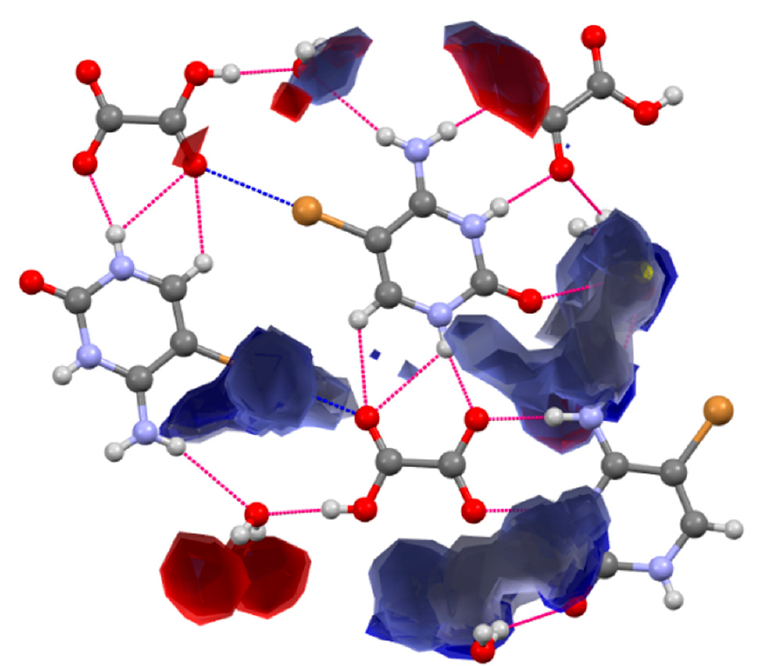
Figure 7. Visualization of the full interaction map calculated around the content of the asymmetric unit for compound ( VI ). Region of HB acceptor and donor likelihood are shown in red and blue, respectively. Acceptor peaks for halogen bonds are shown in violet. Hydrogen bonding is shown as red dashed lines. Halogen bonding is shown as blue dashed